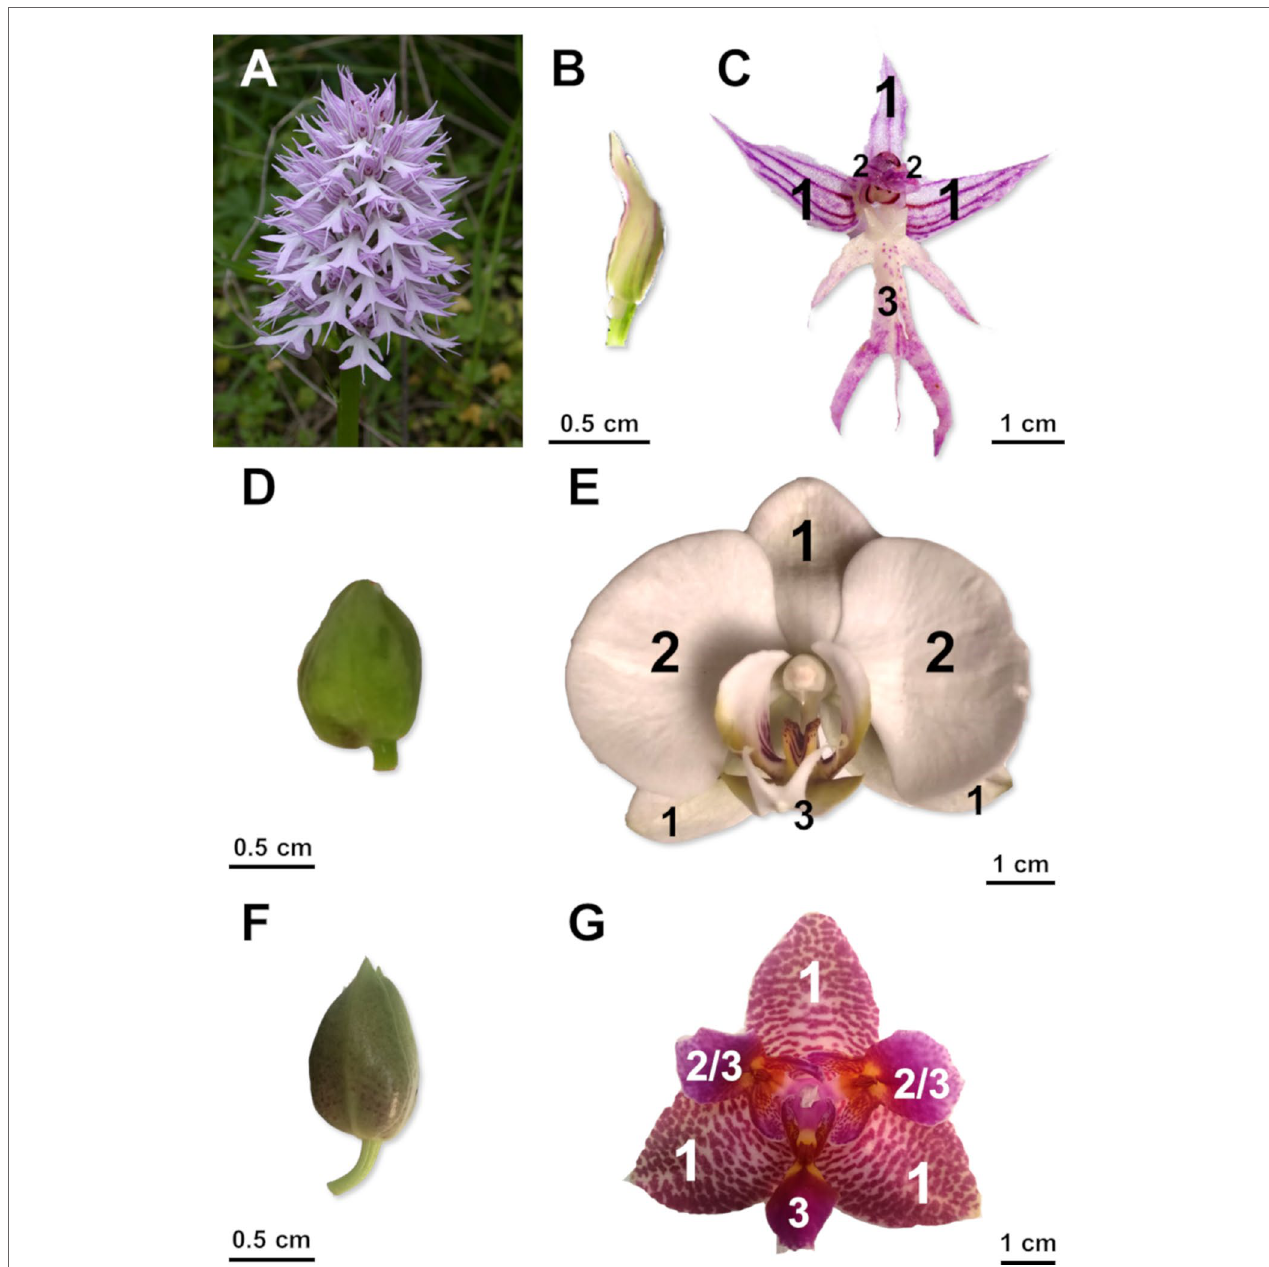
FIgURE 2 | Flowers of zygomorphic and peloric orchids. Orchis italica (Orchidoideae): (A) inflorescence; single flower before (B) and after (C) anthesis. Phalaenopsis equestris (Epidendroideae): flower before (D) and after (E) anthesis. Phalaenopsis Joy Fairy Tale: flower before (F) and after (g) anthesis. 1 , outer tepal; 2 , lateral inner tepal; 3 , lip; 2 / 3 , lip-like structure of Phalaenopsis Joy Fairy